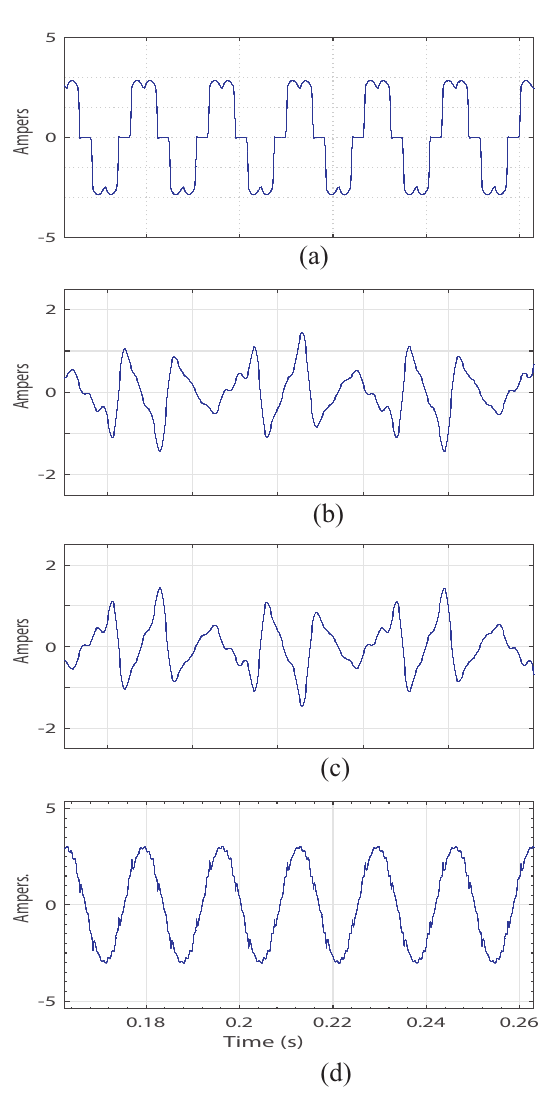
Figure 17. Harmonic current compensation process for phase a : ( a ) grid current without compensation; ( b ) reference filtered current; ( c ) injected current into the system; and ( d ) grid current compensated.